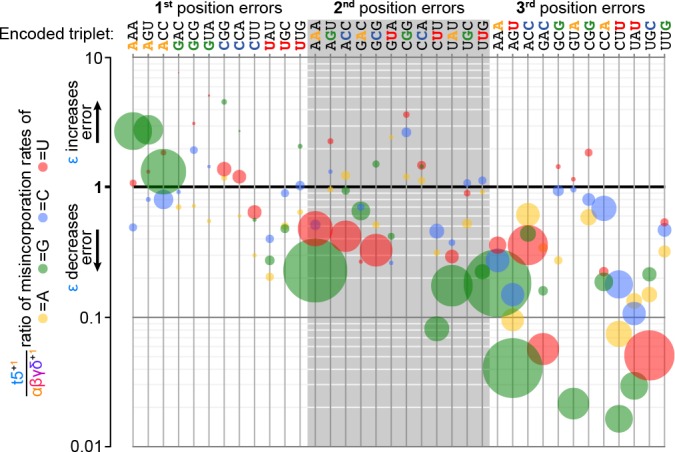
Fidelity domain influence upon template- and position-specific error rates.At each position in each of the twelve triplet templates (top) tested in the fidelity assay (Figure 8a), three different errors are possible after analysis of sequence composition of added triplets (see Figure 8—source data 1). Errors are represented by discs, coloured by mutation (e.g. A to G: green; A to C: blue; G to C: blue). Disc size is proportional to error frequency without the fidelity domain (its occurrence using αβγδ+1). The effect of the ε fidelity domain upon these error tendencies is plotted on the y-axis (by comparison of error rates between t5+1 and αβγδ+1). Many of the most significant errors (using αβγδ+1) exhibit the greatest proportional reductions with the fidelity domain, including substantial (>10 fold) reductions in several misincorporations at the third position. Improvements in fidelity are variable but focused on the second and third triplet positions, while the first triplet position shows an increase specifically in A to G mutations, indicative of a tolerance for G-U wobble pairing.